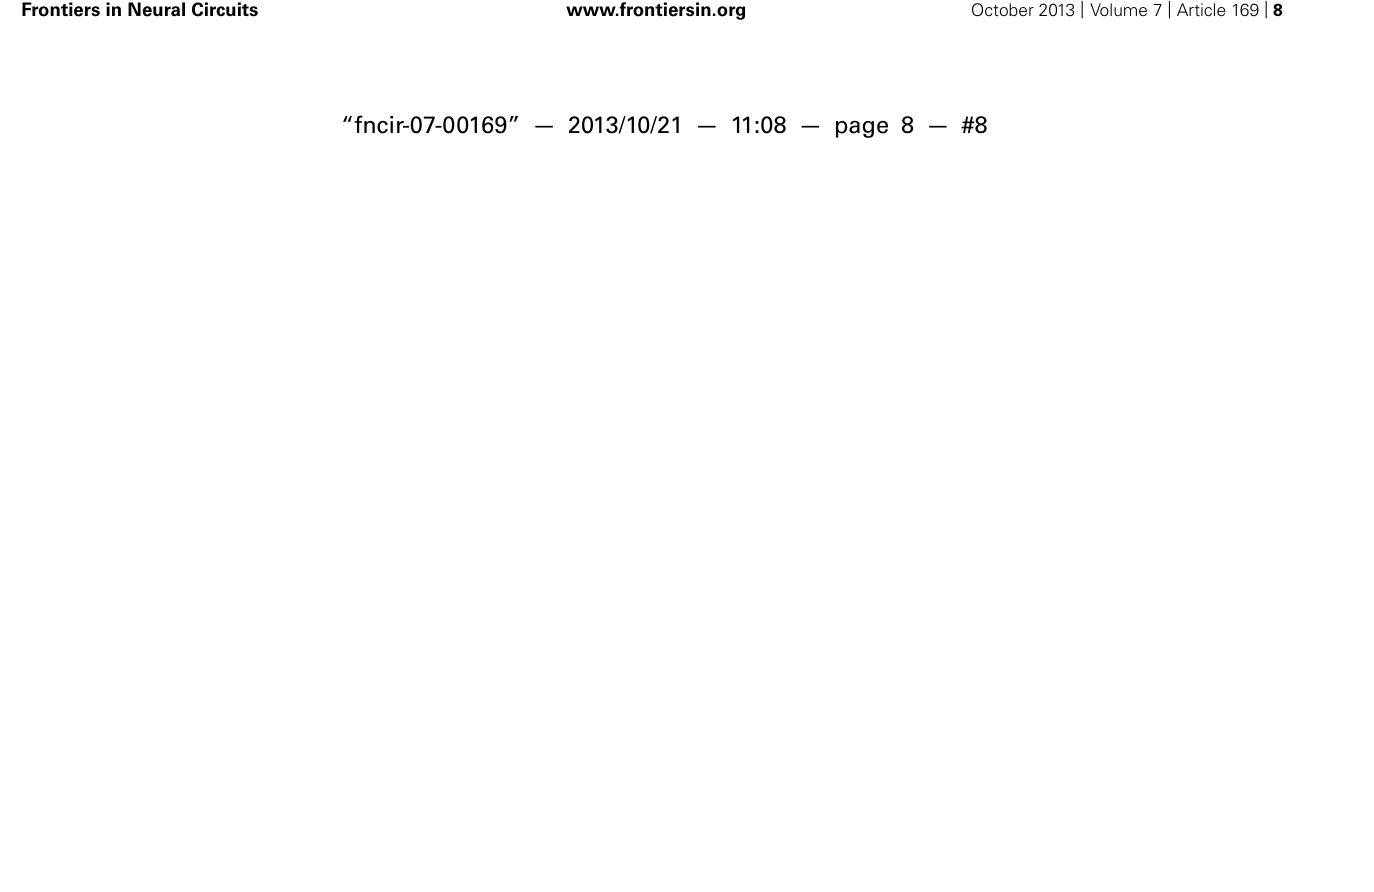
significantly decreased [LP I A : F (3,4) = 19.66, p < 0.0001; LP I h , F (3,4) = 1.218, p = 0.3456]. * p < 0.05. (C) Plot of the fold-changes in the LP I A : I h ratio (mean ± SEM) throughout a 1 h superfusion with 5 μ M DA and implementation of a recurring voltage step that mimicked the DA-induced 30% decrease in LP burst duration and a 10% increase in cycle frequency. The ratio did not change significantly over time (repeated measures ANOVA, see text). (D) Plots of the fold-changes in peak LP I A and I h (mean ± SEM) from the same experiments as in (C) show that both currents are stably altered by 10 min; a and b indicate a significant change in LP I A and I h , respectively, based on repeated measures ANOVA with Dunnett’s post hoc tests that compare all time points to t = 0, p < 0.05 (see